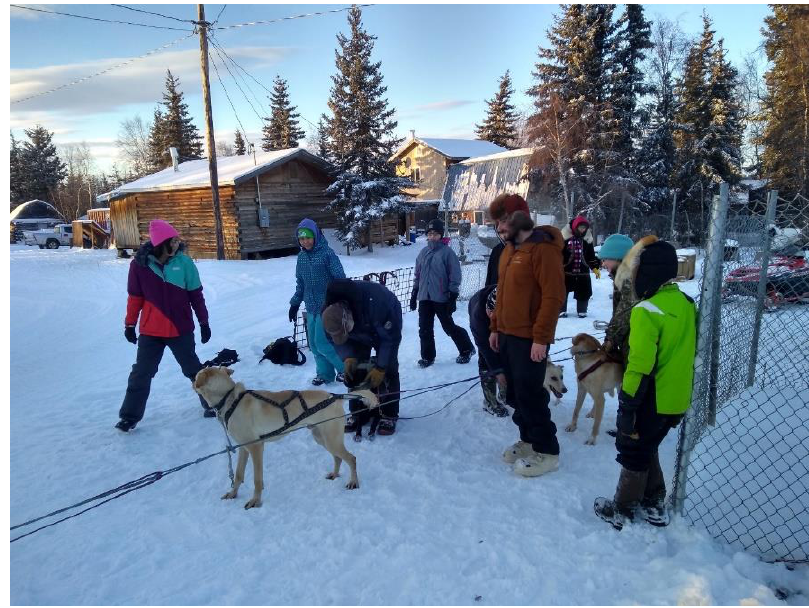
Figure 1. “It’ s a Good Class. Class harnessing team. Shows everyone helping. I like seeing every-